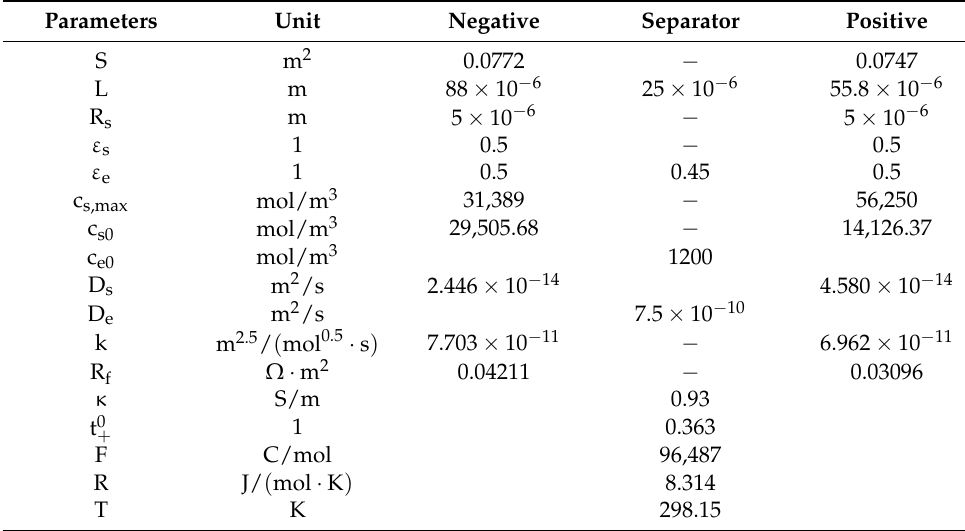
Table 4. Initial electrochemical model parameters of ICR18650-26J battery.